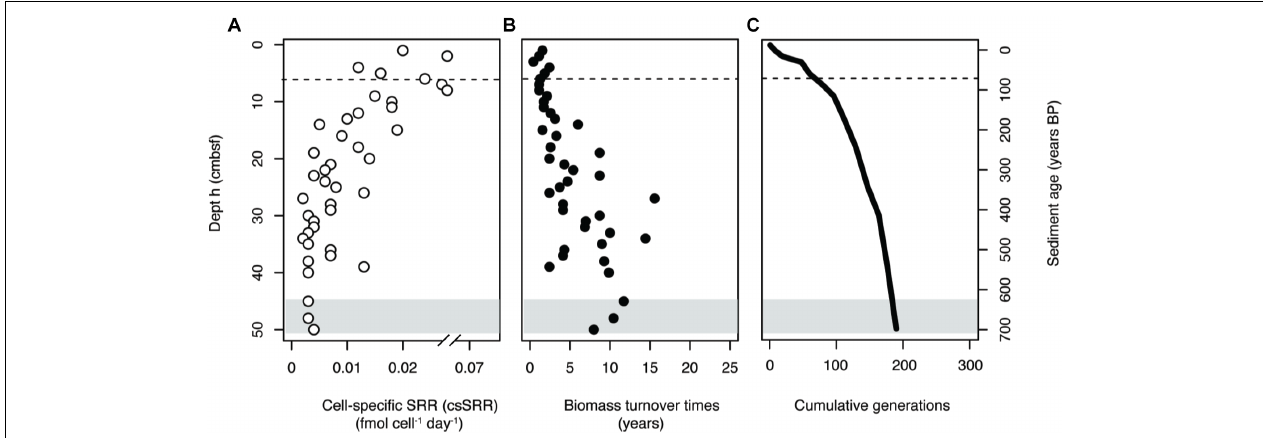
FIGURE 6 | (A) Estimates of cell-specific sulfate reduction rates (csSRR) in the sediment core. (B) Estimated biomass turnover times of the total SRM community. (C) Cumulative generations possible throughout the sediment core. All values were estimated using dsrB gene copy numbers as a proxy for SRM abundance, assuming a 7% DNA extraction efficiency. Gray shading indicates the onset of the SMT. Dashed lines in the surface indicate the bottom of the bioturbation